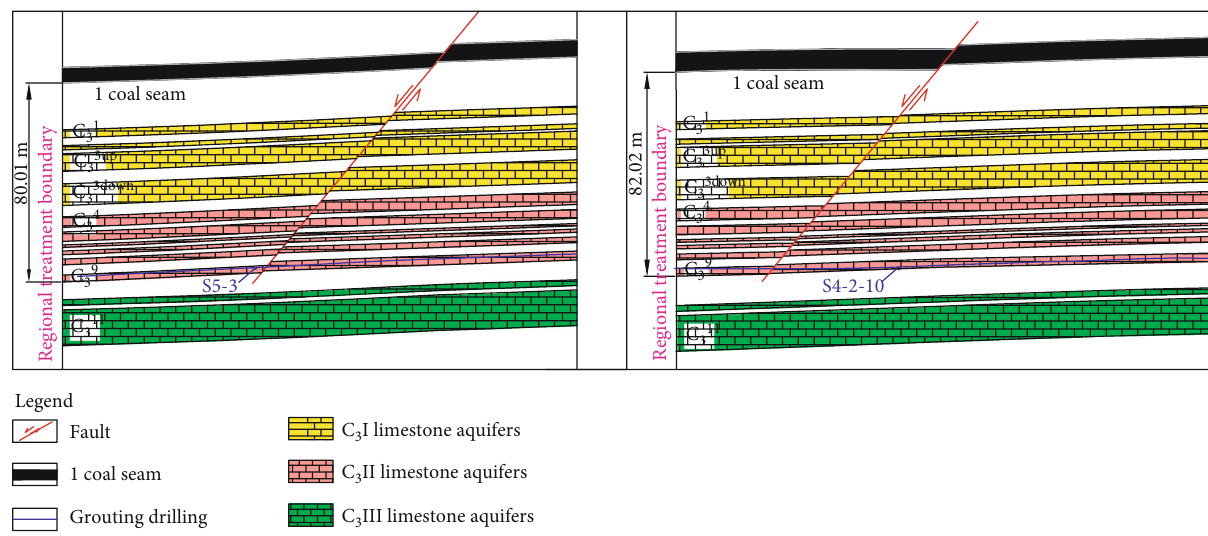
Figure 11: Cross-sectional drawing of S5-3 and S4-2-10, which are located in the C 39 limestone